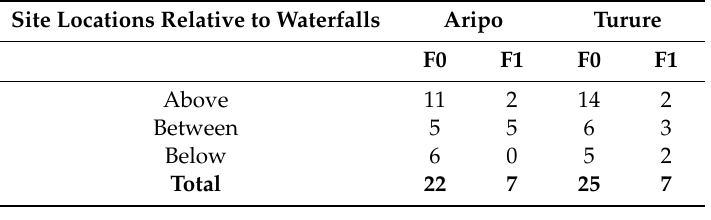
Table 1. Sample sizes (numbers of fish analyzed for rheotaxis) in the Aripo and Turure rivers. The unbalanced design reflects lab mortality.